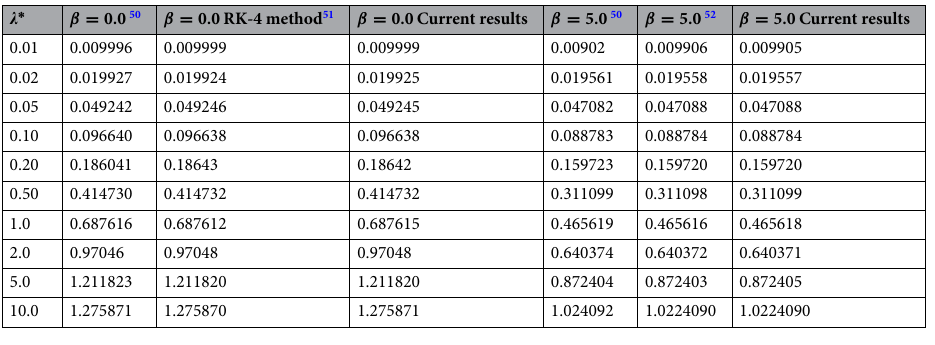
Table 1. Comparative numerical results of f ′′ ( 0 ) with 50–52 when (cid:31) 0 0 0 M Nr Nc E Pe Lb Bi = = = = = = = = = = =